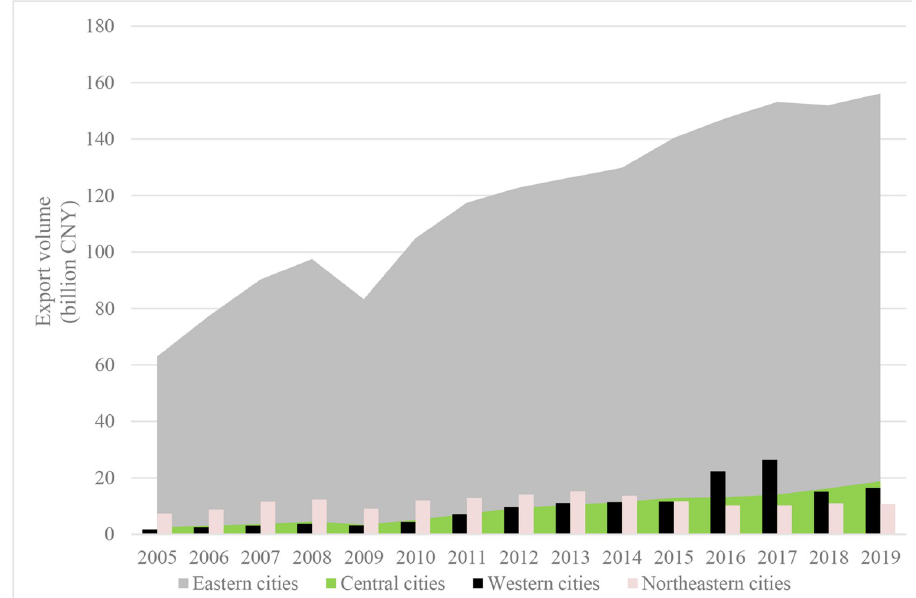
Fig 2. Average city exports at the different geographic